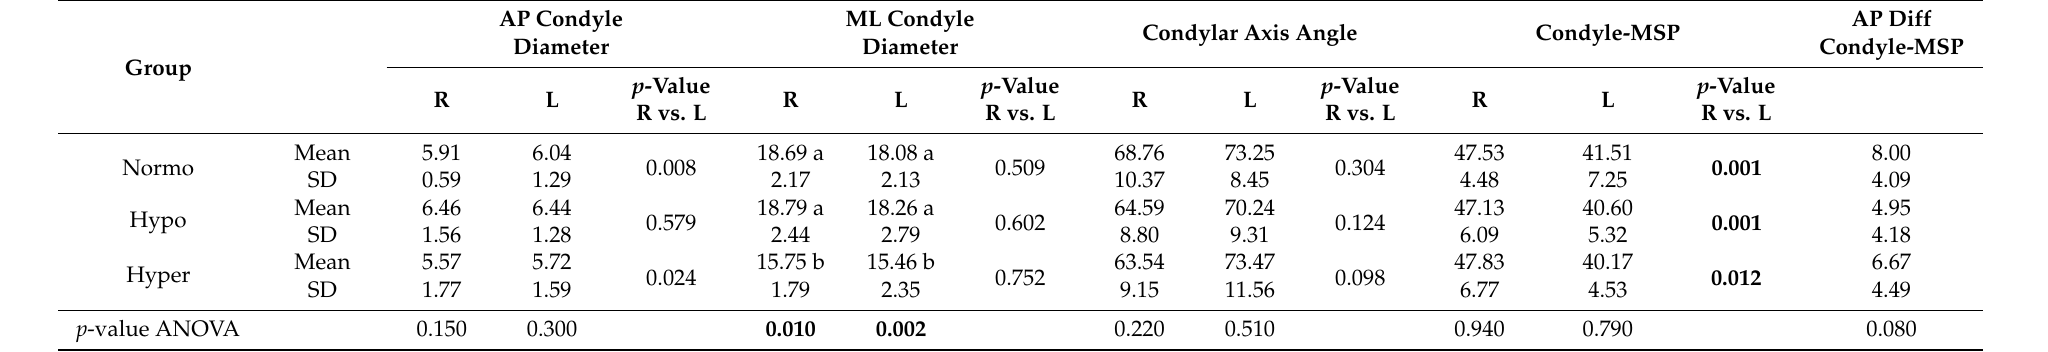
Table 2. Right (R) and Left (L) axial variables, reported as means (mm or ◦ ) and Standard Deviations (SD) in the three study groups (Normo: Normodivergent; Hypo: Hypodivergent; Hyper: Hyperdivergent). Statistically significant p -values are reported in bold. Different letters indicate statistically significant difference between groups in the Tukey Post Hoc